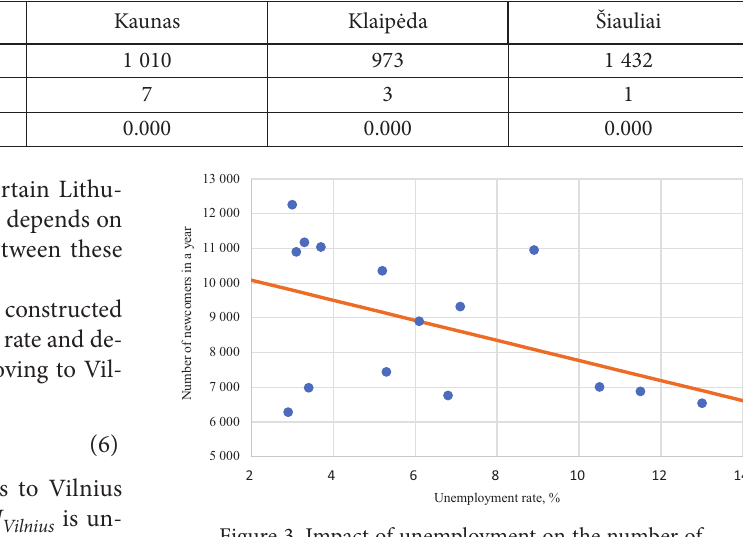
Figure 3. Impact of unemployment on the number of newcomers to Vilnius in 2005−2019